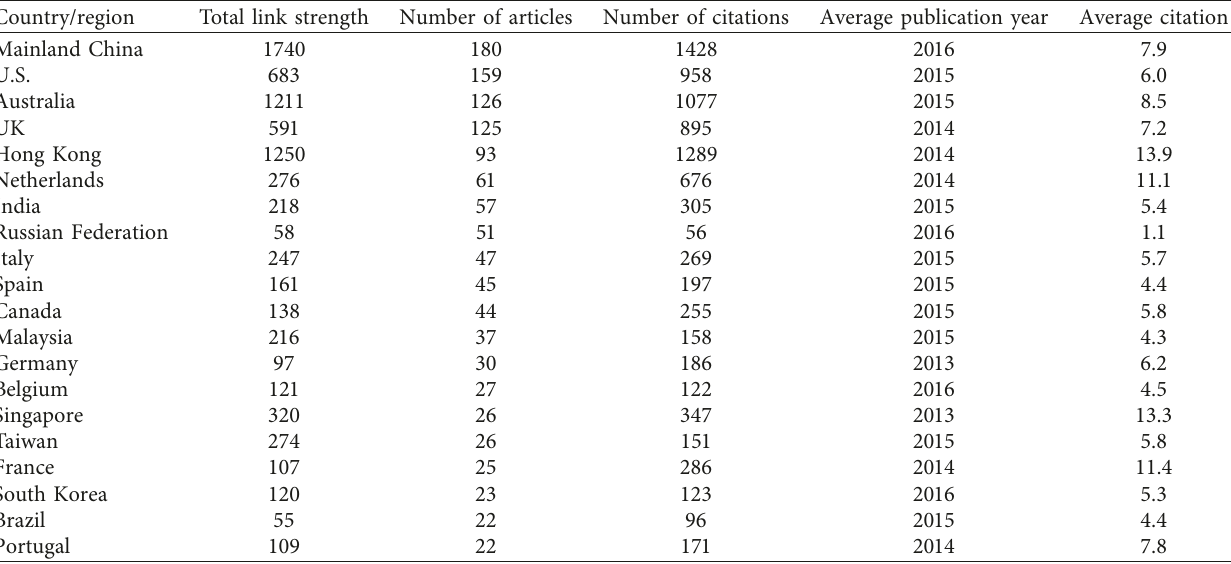
Table 6: Countries or regions where PPP researchers are based.